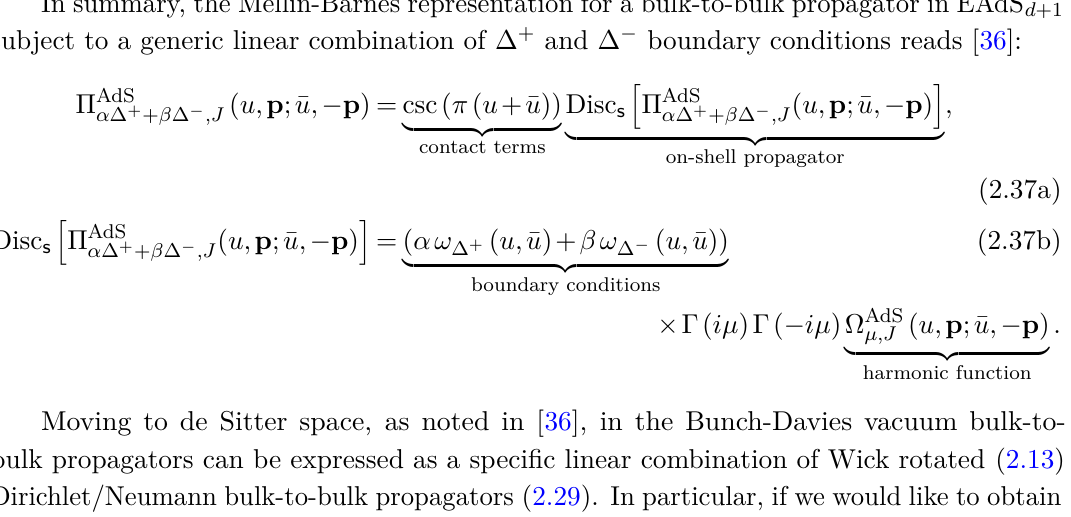
Figure 7. Bulk-to-bulk propagators in (EA)dS take a universal form in the Mellin-Barnes repre- sentation, which on-shell is given by the harmonic function multiplied by the appropriate linear combination of projectors ω ( u, ¯ u ) implementing the boundary condition. The full propagator is ∆ ± reconstructed from its on-shell part by multiplying with the factor csc ( π ( u + ¯ u )) . In summary, the Mellin-Barnes representation for a bulk-to-bulk propagator in EAdS